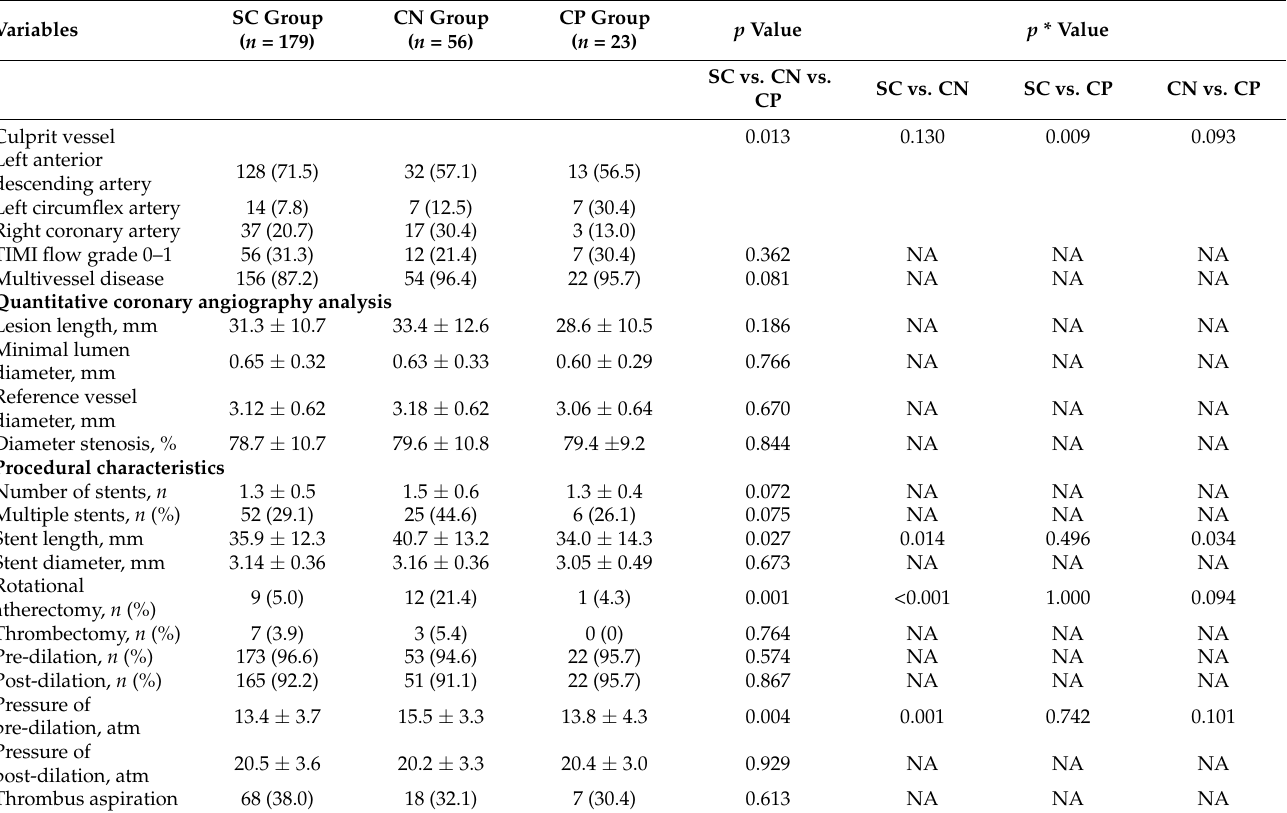
Table 2. Angiographic findings and procedural characteristics of different calcified culprit